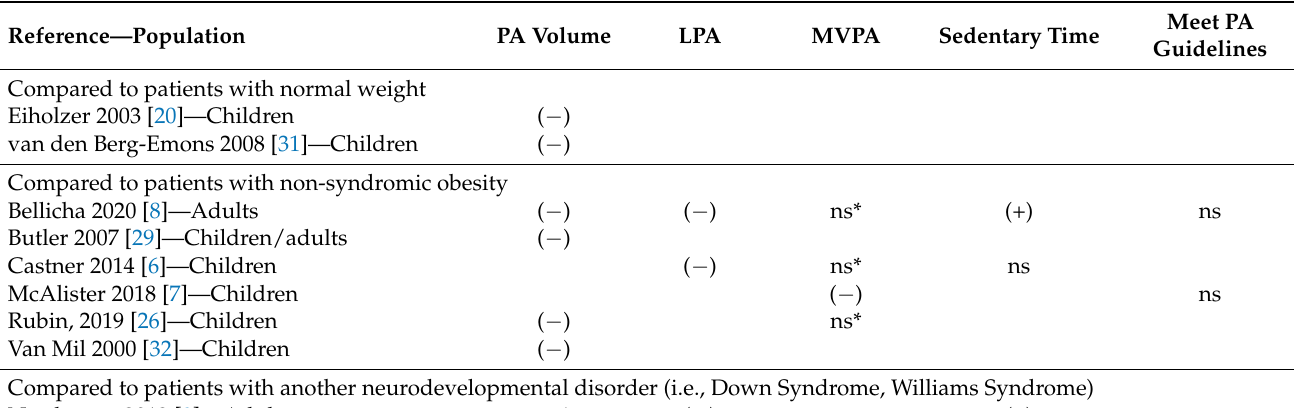
Table 2. Habitual PA and sedentary behavior assessed with pedometers or accelerometers in patients with PWS compared to